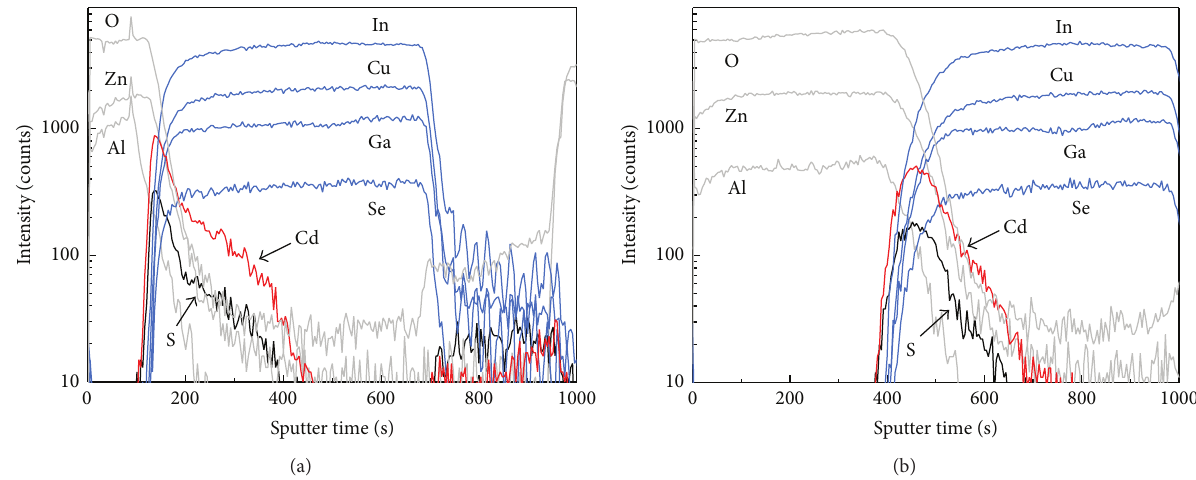
Figure 4: TOF-SIMS depth profiles of ZnO:Al/CdS/CIGS region in (a) a low thermal budget grown device with 𝜂 = 10.9 % and (b) a high thermal budget device with 𝜂 = 1.3 %. Note that the onset of the constituent elements within CdS and CIGS layers are shifted along the 𝑥 -axis in (b) since the device had a thicker ZnO:Al front contact.